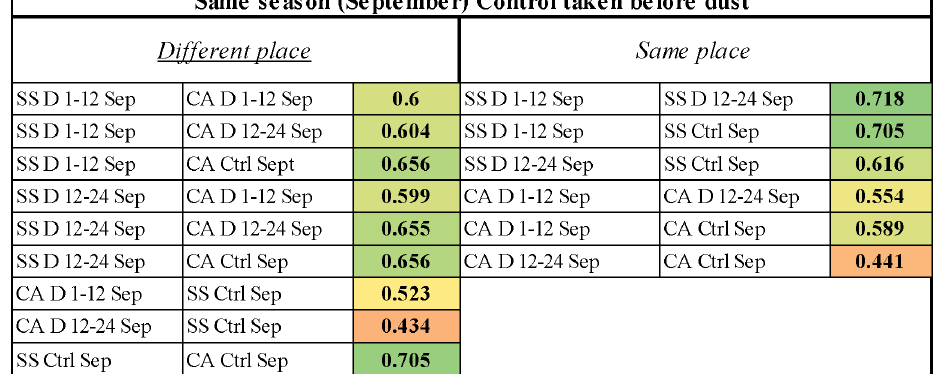
Figure 6. Bray–Curtis similarity values between the bacterial community composition resulting from pairwise comparisons of all samples. SS: Sassari; CA: Cagliari; D1–12: dust event, first 12h period; D12–24: dust event, second 12h period; Ctrl: control conditions (absence of dust events); Sep: